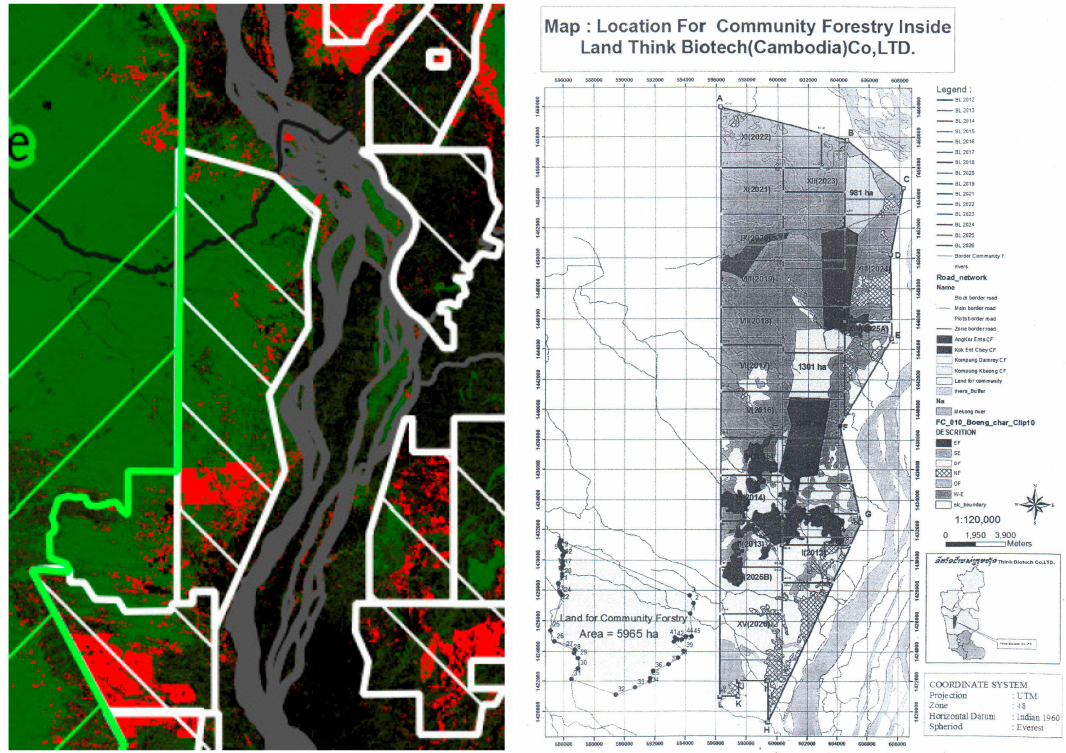
Figure 5. Think Biotech (TB) forest cover map ( left ). Think Biotech project map with four CFs labeled ( right ).